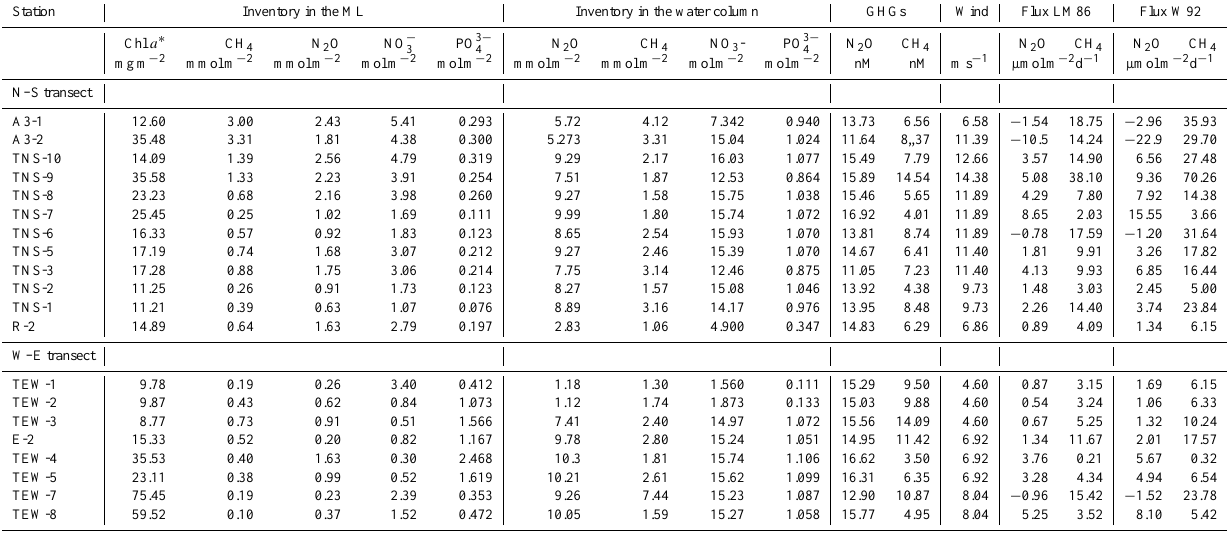
Table 2. Inventories of gases and nutrients estimated in the mixed layer (ML) and the entire water column, along with GHG concentrations, wind velocities and concomitant estimated gas exchange across the air–sea interface. Station Inventory in the ML Inventory in the water column